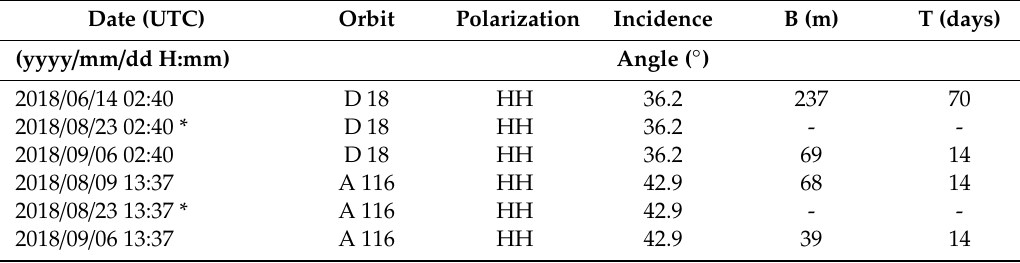
Table 1. Detailed information of the PALSAR-2 data. B, and T are normal baseline and temporal baseline, respectively. * In both the ascending and descending datasets indicates the master image.